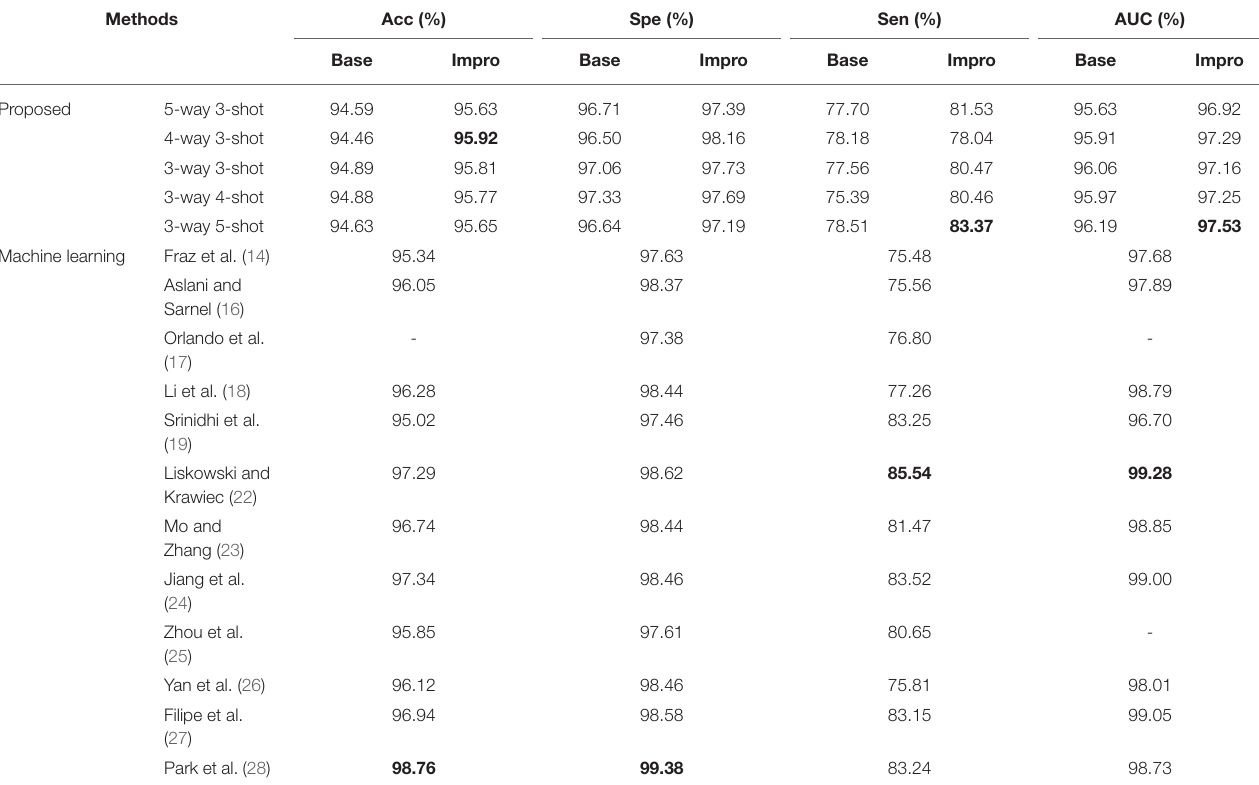
TABLE 3 | Performance comparison on STARE.